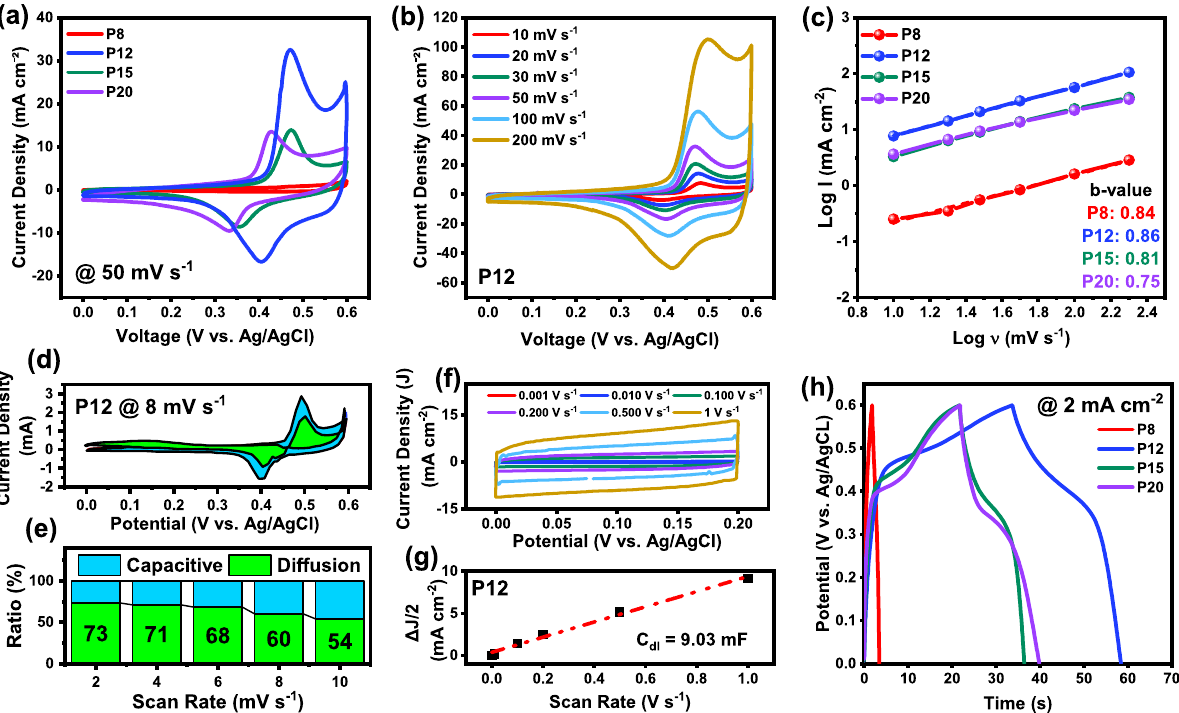
Figure 5. ( a ) CV profile of all four samples presented at 50 mV s −1 ( b ) CV profile of P12 under multiple scan rates ( c ) log ( i ) vs log (scan rate) to find b-value using power law ( d ) A separation of diffusion controlled and surface capacitive contribution of P12 CV ( e ) Bar chart defining the contribution ratio of P12 at increasing scan rates ( f ) CV profile of NiO/CuO hybrid structure of P12 in capacitive narrow voltage window ( g ) The ECSA calculated by taking current density in f and plotting against scan rate ( h ) GCD of all samples with